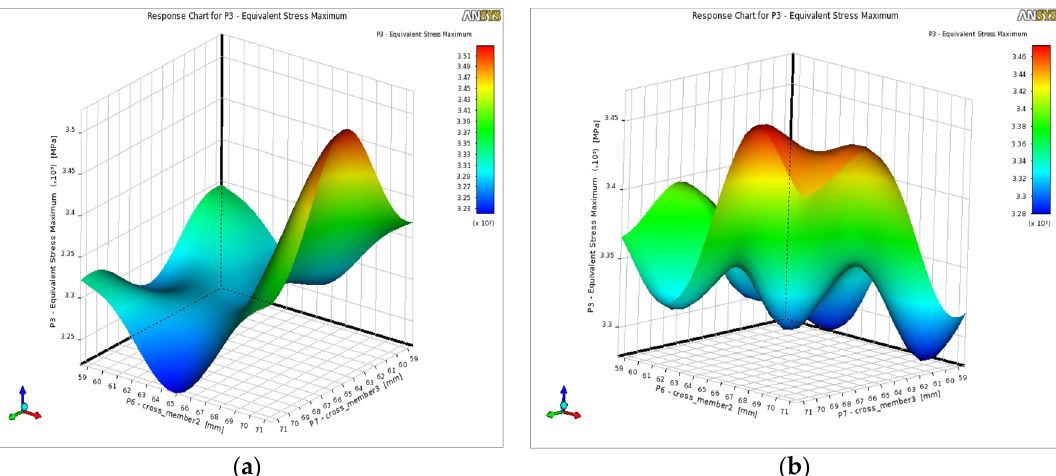
Figure 19. Response surface plot of equivalent stress vs. cross member 2 and cross member 3 ( a ) for CCD scheme, and ( b ) for optimal space filling design.